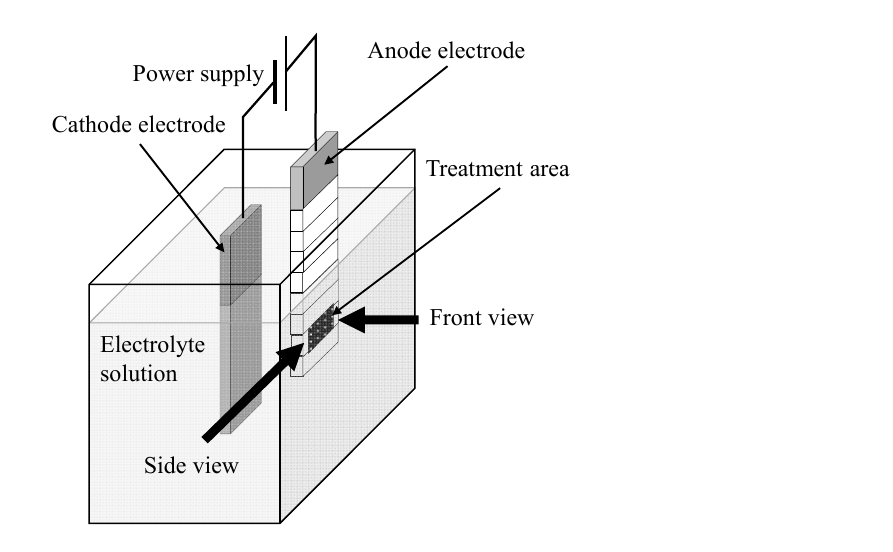
Figure 2. Experimental apparatus of the PEO process for the Ti-15-3 and observation direction of micro-arcs, ejected materials, bubbles, and coating surface during the PEO process.